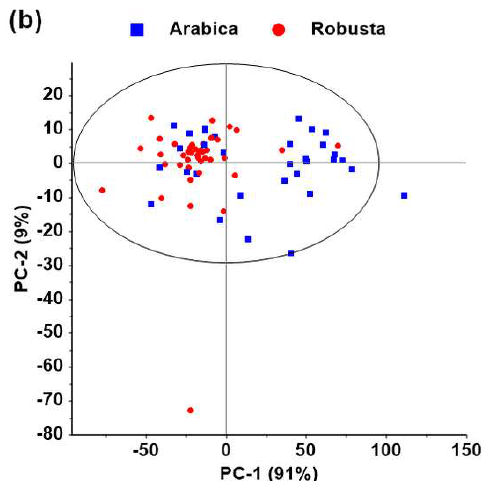
Figure 3. Mean diffuse reflectance (log 1/R) of raw spectra ( a ); score plot of principal component analysis using raw near-infrared spectra (log 1/R) with Hottelling’s T 2 ellipse for outlier inspection. Samples outside the Hottelling’s T 2 ellipse are considered spectral outliers ( b ).